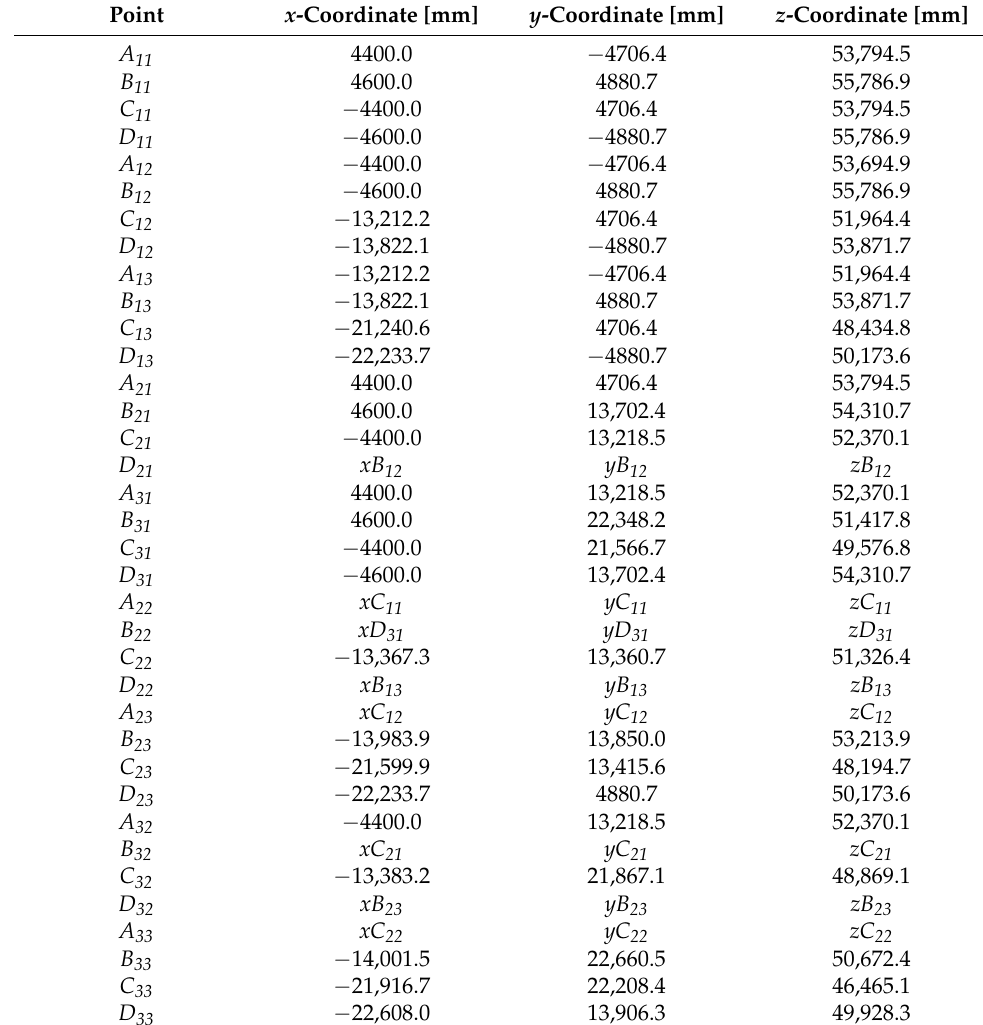
Table A8. The coordinates of the vertices A ij , B ij , C ij , D ij (for i, j = 1, 2, 3) of the first modified configuration CP1 of the eaves edge net B v 1